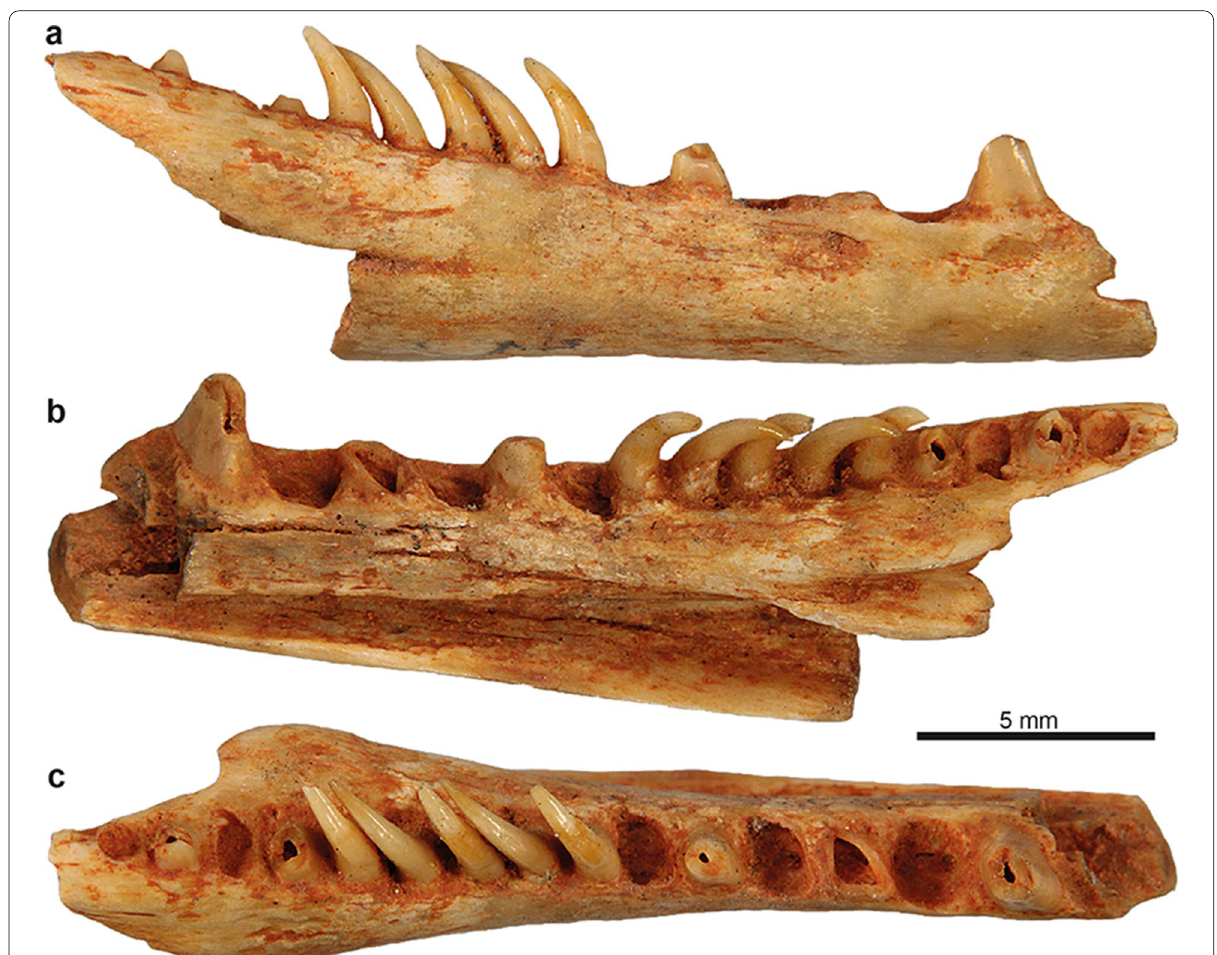
Fig. 100 Phosphoroboa filholii comb. nov. from an imprecisely known locality near Mouillac, Phosphorites du Quercy: a right dentary (NHMUK PV R 3489) in labial ( a ), medial ( b ), and dorsal ( c )